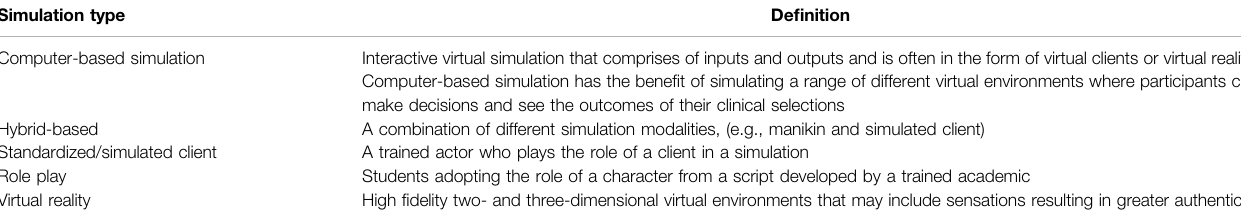
TABLE 1 | De fi nitions of the types of